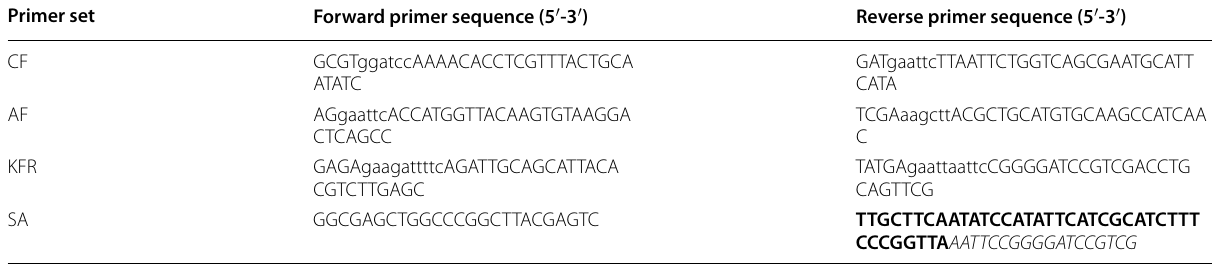
Lower case type indicates an engineered restriction enzyme site Underlined-case type indicates complementary sequences to Salmonella sipA gene loci Bold case type indicates complementary sequences to nucleotide sequences downstream sipA gene loci Italic case type indicates complementary sequences to kan R gene